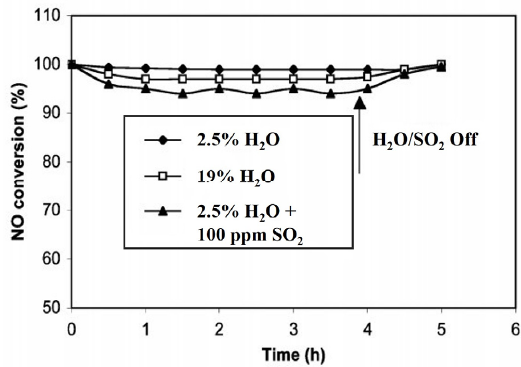
Figure 4. The effect of on-stream time on SCR activity with H 2 O + SO 2 and without H 2 O + SO 2 (Reaction conditions: 120 °C, [NH 3 ] = [NO] = 1000 ppm, [O 2 ] = 2%, GHSV = 42,000 h − 1 . Catalyst: MnO x (0.3)–CeO 2 ). (Reproduced with permission from Reference [24], Copyright 2003, The Royal Society of Chemistry).